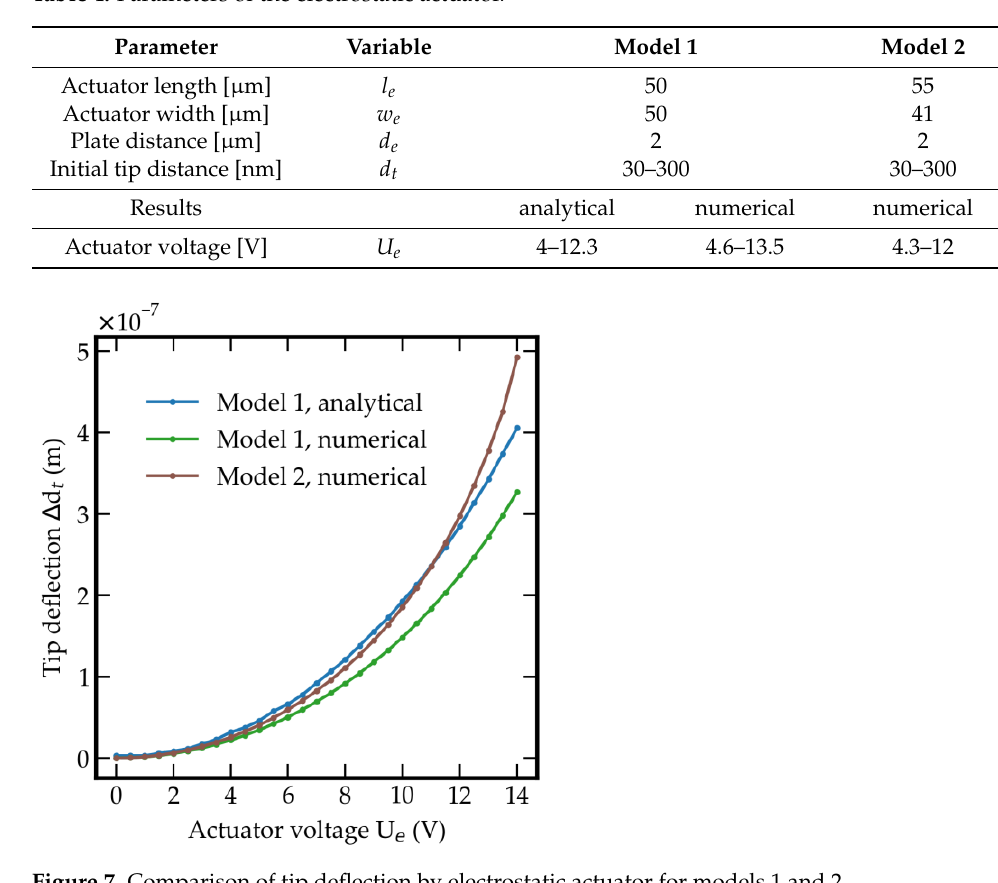
Figure 7. Comparison of tip deflection by electrostatic actuator for models 1 and